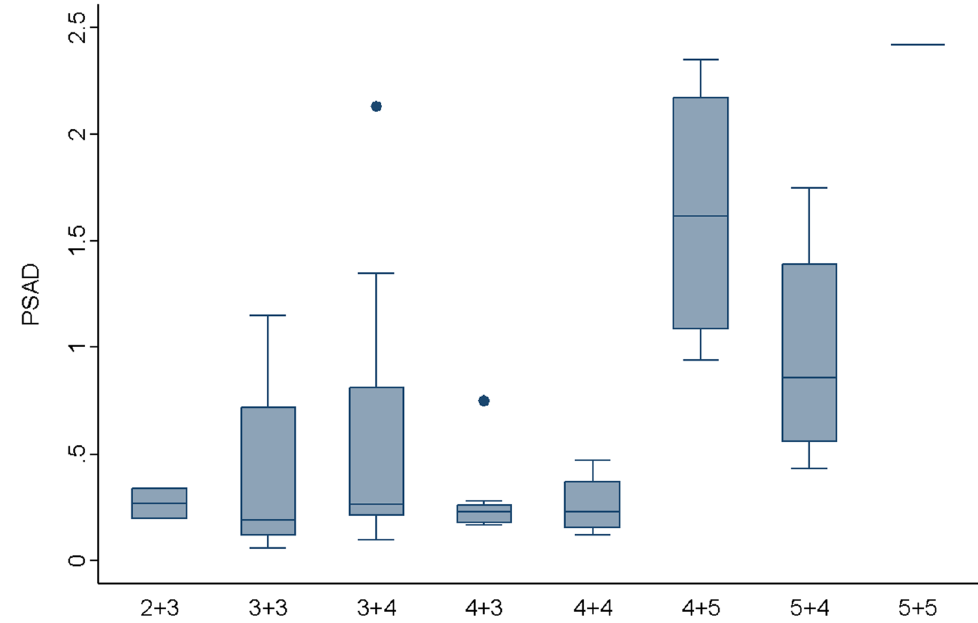
Fig. 3 Correlation between PSAD and gleason